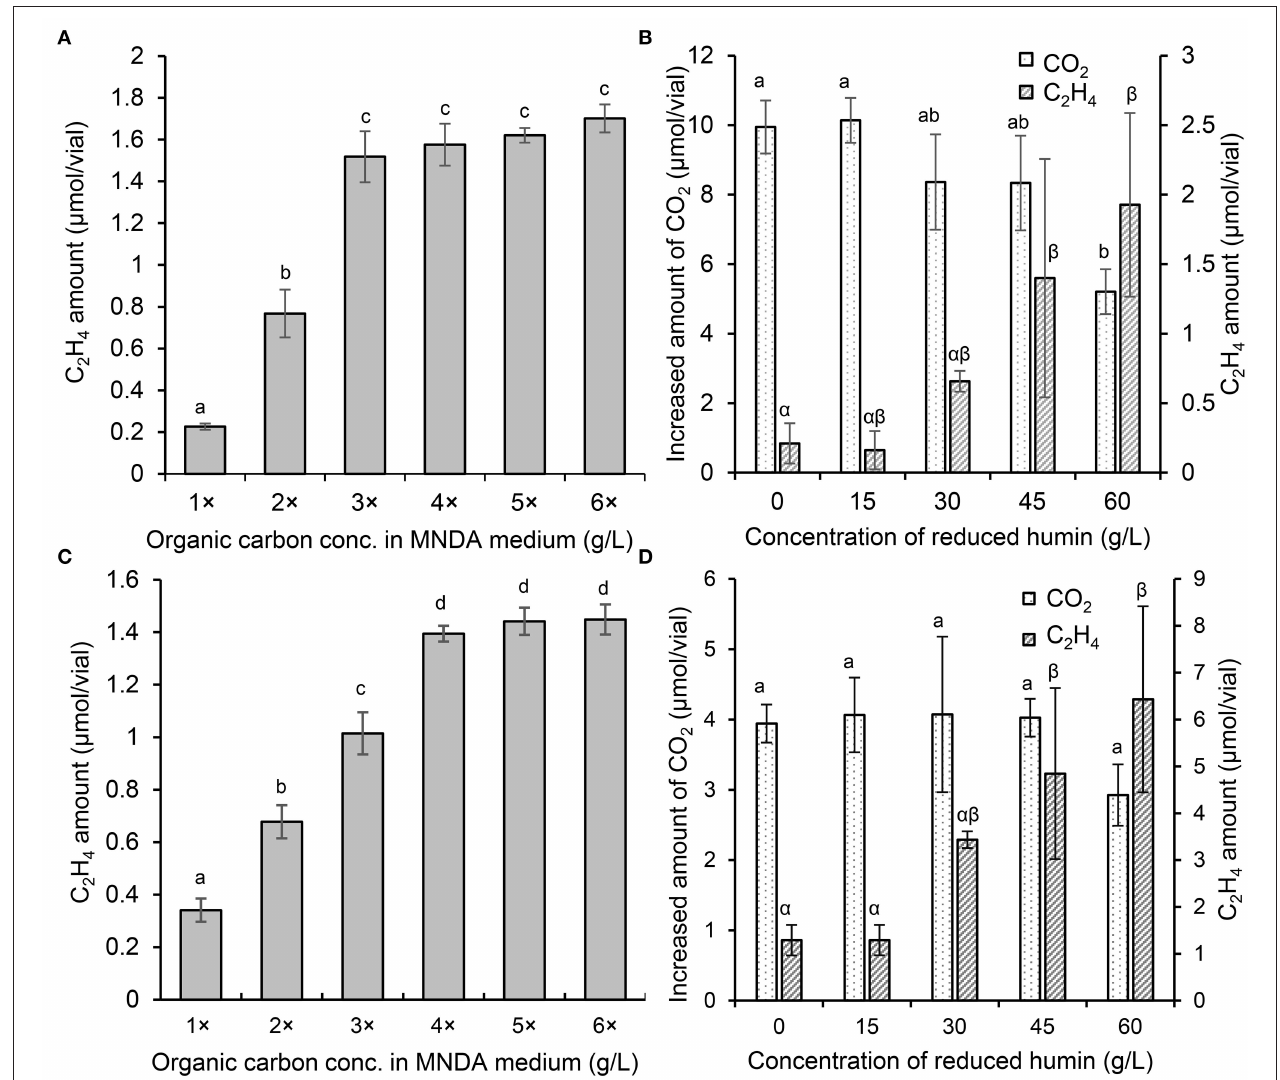
FIGURE 4 | ARA and the increased amount of CO 2 in the cultures of E. fredii and C. pasteurianum with different concentrations of organic carbon and the reduced humin. Ensifer fredii was incubated under molybdenum conditions, and C. pasteurianum under vanadium conditions, respectively. The ARA of E. fredii (A) and C. pasteurianum (C) in anaerobic medium with different concentrations of organic carbon. The ARA and the CO 2 production in the cultures of E. fredii (B) and C. pasteurianum (D) with saturated organic carbon concentration and different concentrations of the reduced humin over seven days. No ARA was detected on day 0 or in the abiotic controls. Different letters indicate the significant difference at p <